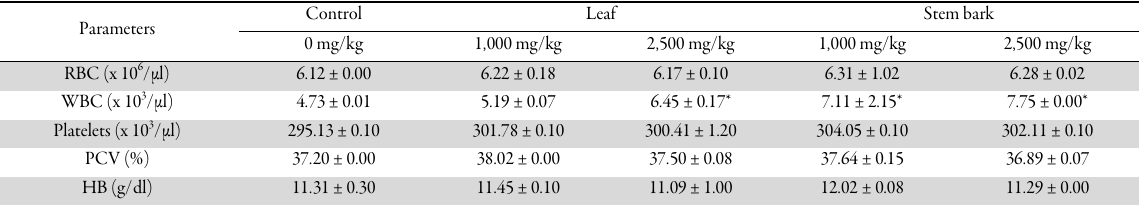
Table 3. The effect of leaf and stem bark extract of Cola millenii on blood parameters of rats